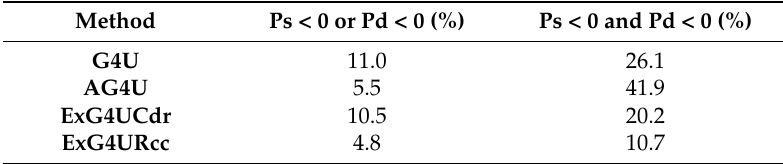
Figure 7. Decrements of the T 33 term via different angle compensations on the selected lines: ( a , b ) decrements along the white line for C- and L-band data, respectively; and ( c , d ) decrements along the black line for C- and L-band data, respectively. Table 5. Percentage of pixels with negative scattering powers for C-band data.